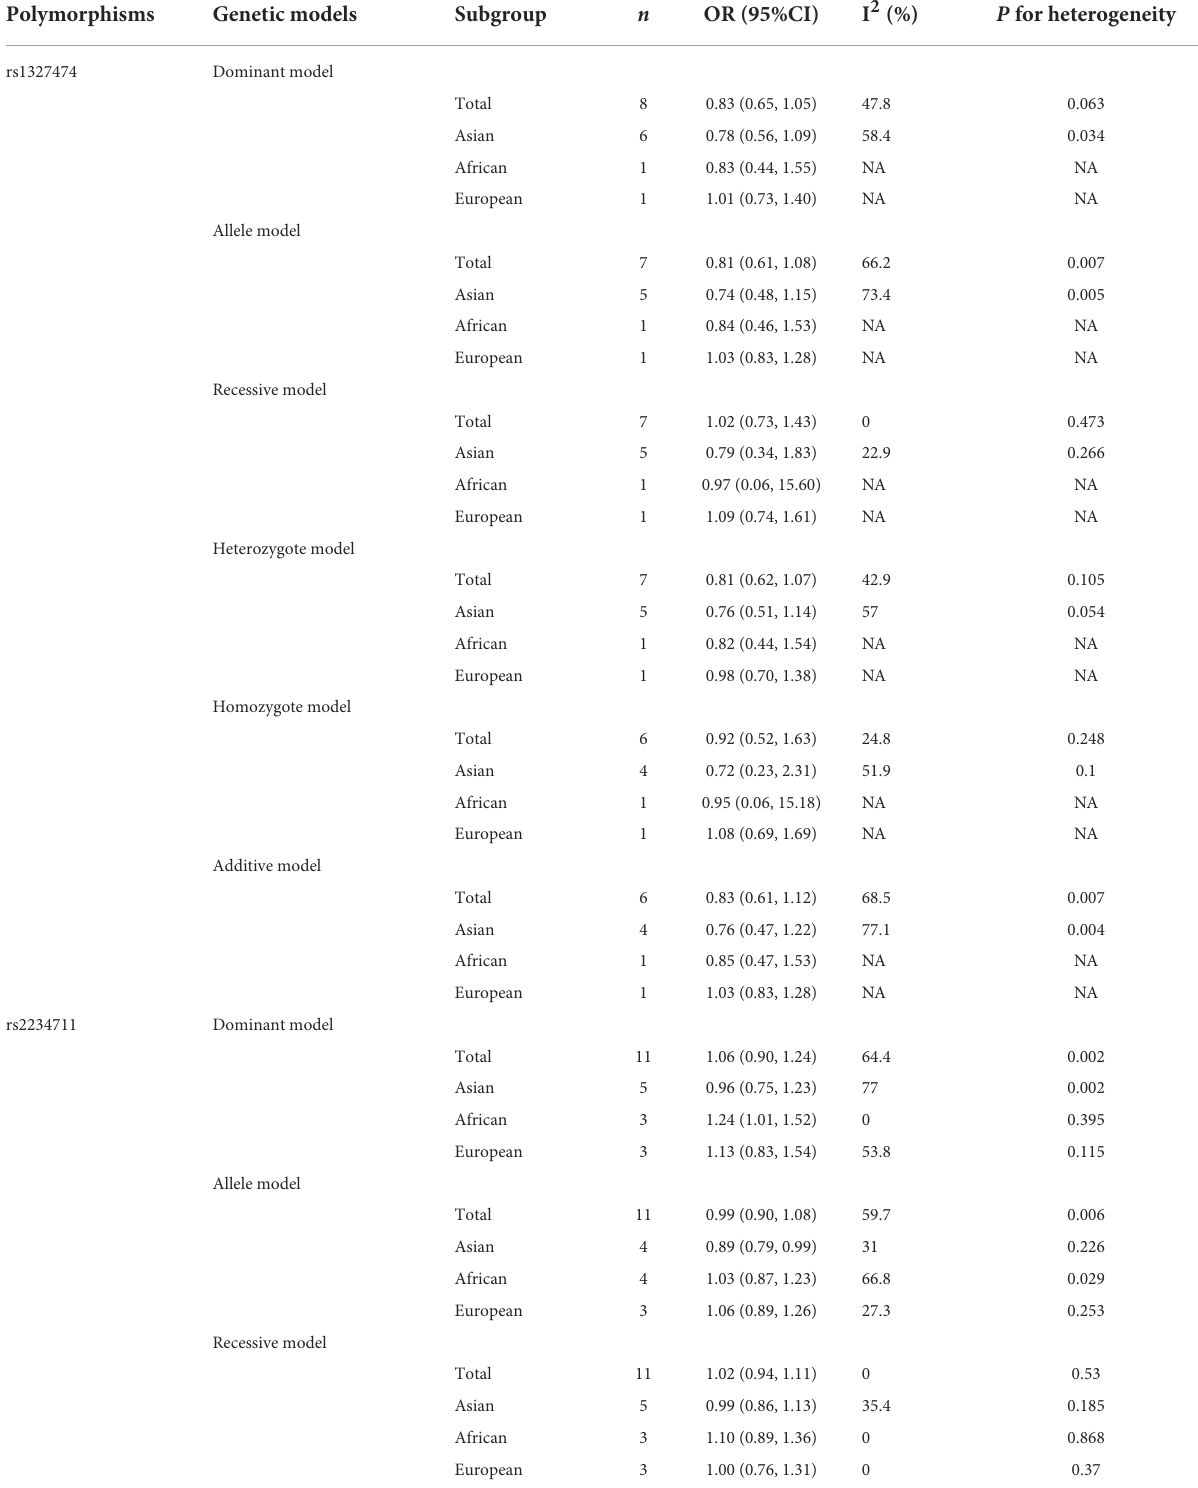
TABLE 2 Results of association between IFNGR1 gene polymorphisms and TB